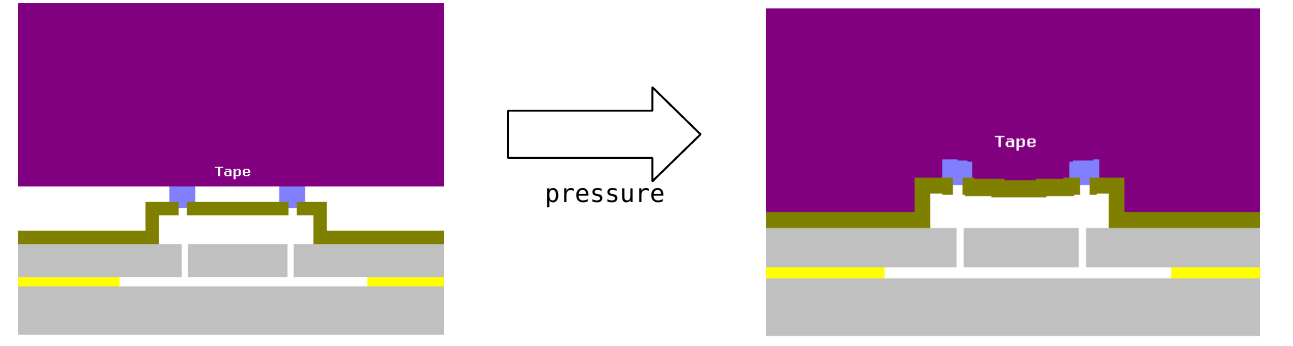
Figure 4. Tape application to the front side of a wafer.